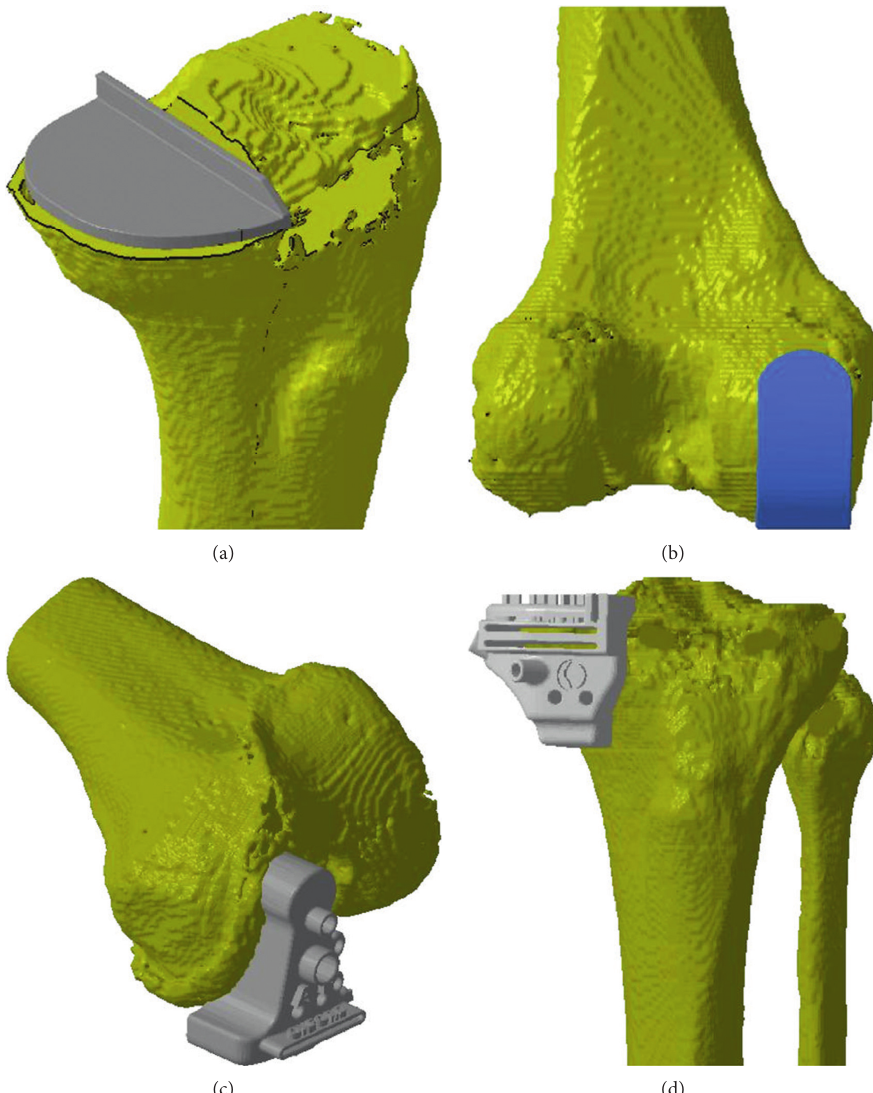
Figure 3: UKA planning showing the sizing, alignment, and implant positioning that matches the patient’s